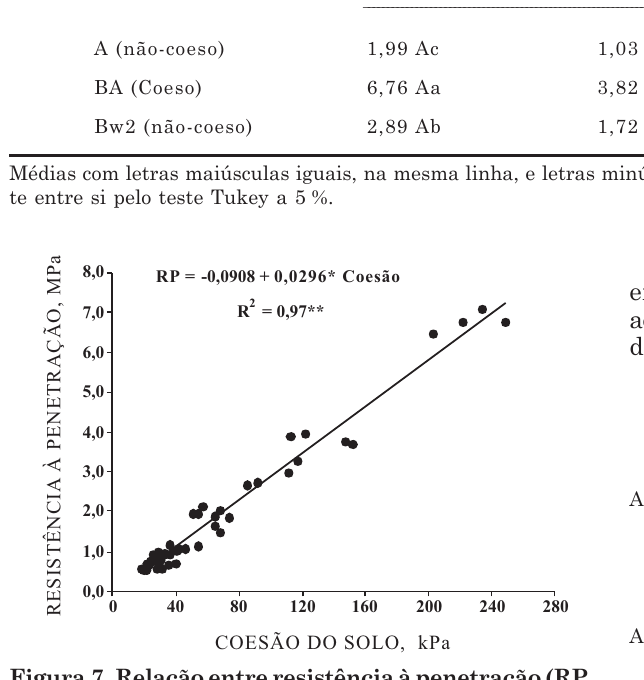
Figura 7. Relação entre resistência à penetração (RP, MPa) e coesão (kPa) de um Latossolo Amarelo de São Miguel dos Campos, Al, nos teores de água de 0,07, 0,12, 0,19 e 0,24 kg kg -1